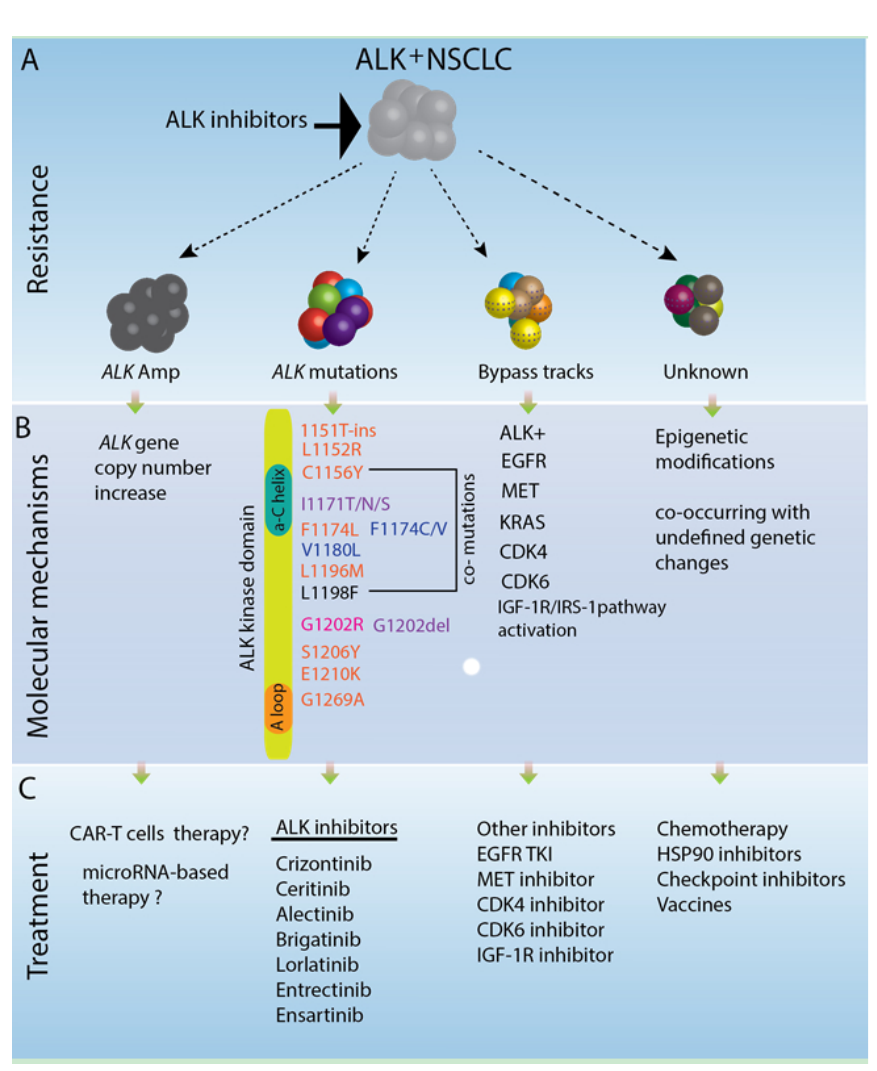
Figure 2. Resistance mechanisms in ALK fusion-positive lung cancer. A subset of lung cancer is driven by clonal ALK -rearranged genetic alterations. Top panel ( A ) depicts general categories of ALK tyrosine kinase inhibitor (TKI) resistance mechanisms. The oncogene-addicted ALK + lung cancer cells initially respond to ALK tyrosine kinase inhibitors treatment (e.g., crizotinib treatment) followed by relapse due to acquired resistance, via ALK gene amplification, and/or ALK mutations, and/or bypass track activation or other unknown mechanisms. Middle panel ( B ) delineates the molecular mechanisms of each ALK TKI resistance phenotypes in addition to ALK rearrangement genetic alteration. Acquired mutations in ALK kinase domain are a well-known underlying molecular mechanism of ALK TKI resistance. Resistance mutations are listed here, highlighted with different colors: pink, crizotinib resistance; blue, alectinib resistance; and purple, ceritinib resistance. The ALK G1202R mutation is resistant to crizotinib, alectinib, and ceritinib. Rare compound mutations such as C1156Y and L1198F are resistant to loratinib, but sensitive to crizotinib, details see reference [19]. Bottom panel ( C ) lists treatment options for different types of ALK TKI resistance. Many FDA-approved ALK inhibitors (e.g., crizotinib, alectinib, and ceritinib) could be used to target acquired TKI resistance; other small molecules (e.g., EGFR inhibitors, MEK inhibitors, MET inhibitors, CDK4/CDK6 inhibitors or IGF-1R inhibitors) could be used to target bypass tracts with coexisting genetic alterations. Conventional chemotherapy, HSP90 inhibitor, immunotherapy and cancer vaccines are other options to treat the remaining subset of inhibitor-resistant ALK positive lung cancers. For ALK gene amplification resistant cases, chimeric antigen receptor-T cells therapy or microRNA-based therapy may be investigational treatment